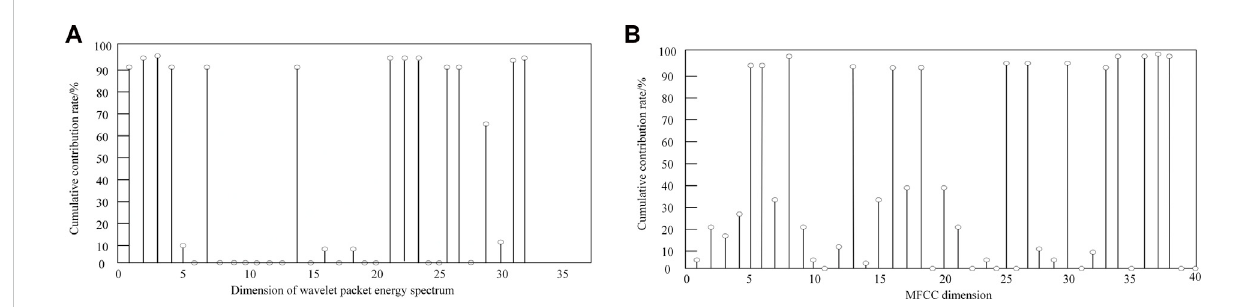
FIGURE 6 Cumulative contribution rate of wavelet packet energy spectrum and